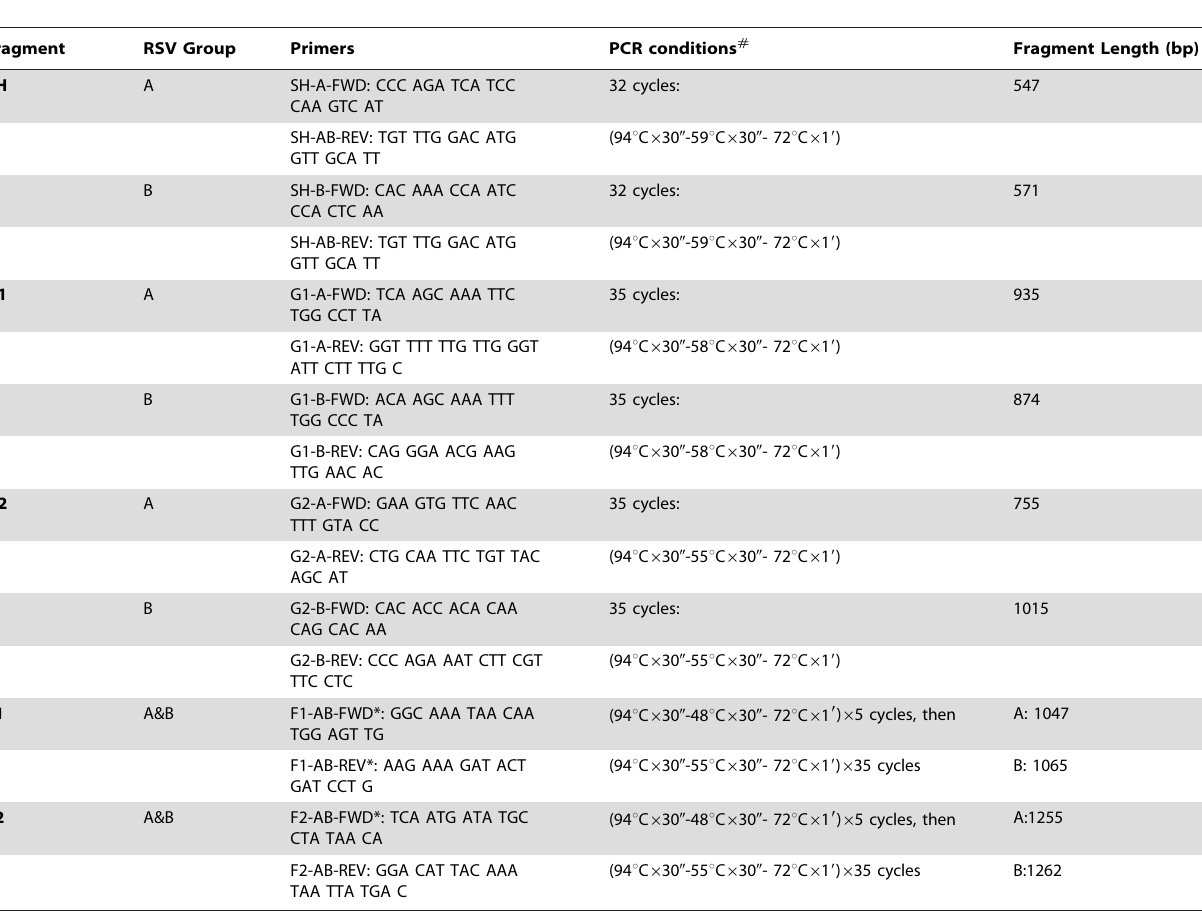
Table 1. Primers and specific conditions used for PCR amplification of RSV surface proteins